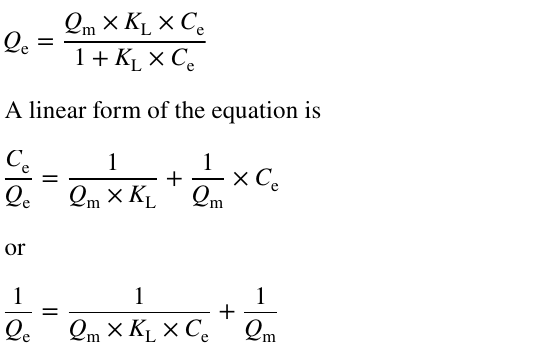
Fig. 2 Removal efficiencies ( R different adsorbent